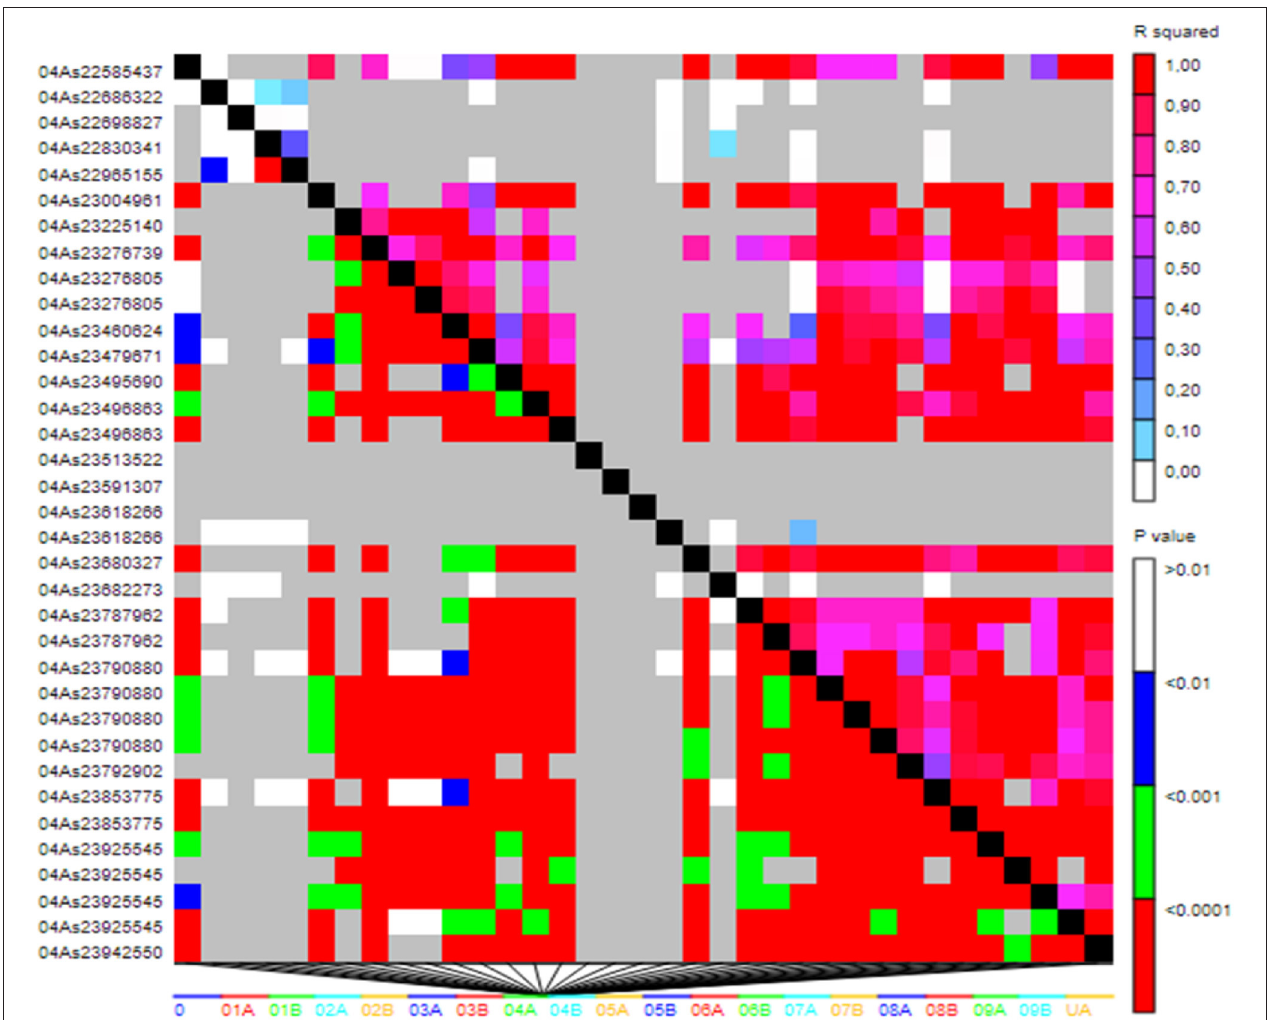
FIGURE 6 | LD patterns plot based on 17,045 SNP markers. The relationship between two markers is represented by each cell with the color codes for the presence of significant LD. In both diagonals, colorful bar codes are shown for the significant threshold levels.